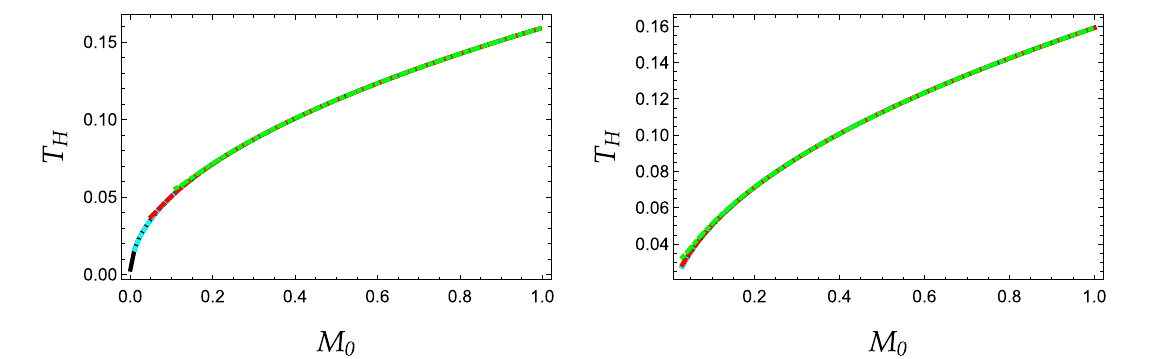
Fig. 4 Blackholetemperature T H againsttheclassicalblackholemass M 0 for different values of the parameter ξ . Left panel: Exact black hole temperature obtained numerically by solving Eq. (36), versus M 0 . Right panel: Approximated black hole temperature obtained for a small